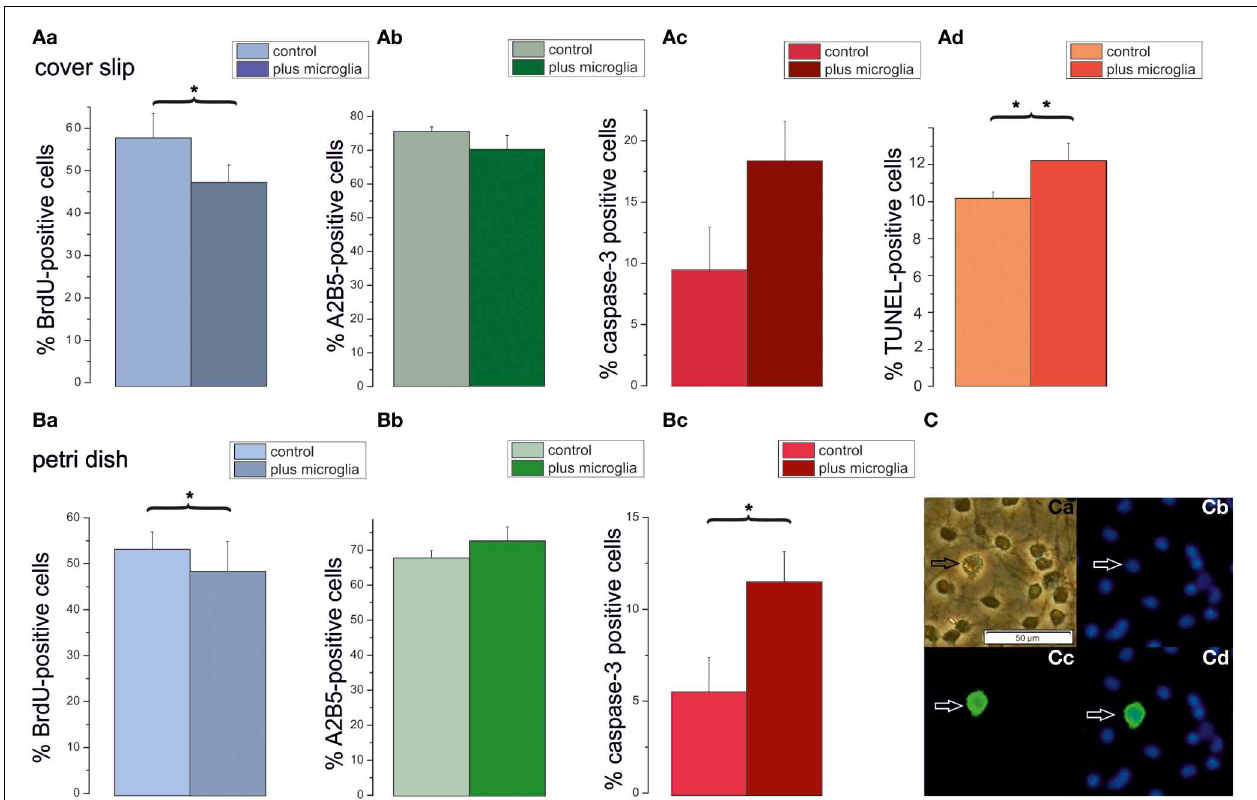
FIGURE 8 | Impact of additional microglia on OPCs cultured on cover slips or petri dishes. Cells plated with a seeding density of 5000 cells/coverslip were cultured in DMEM based proliferation medium for 3 days (control) or co-cultivated with an added density of microglia (plus microglia), as counted in high density cultures (80,000 cells/coverslip) in proliferation medium. Bar graphs (Aa–Ad) display percentages of OPCs cultured on coverslips. (Aa) BrdU-positve cells. (Ab ) A2B5-positive cells. (Ac) : Caspase-3-positive cells, (Ad) TUNEL positive cells, 6 cover slips from 3 preparations investigated. Bar graphs in (Ba–Bc) display